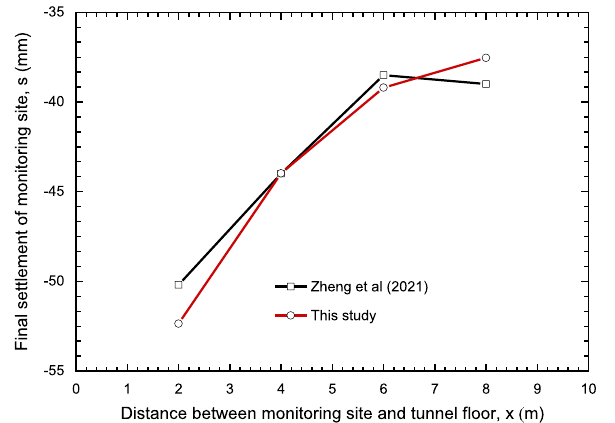
Figure 10. The numerical model and monitoring results.